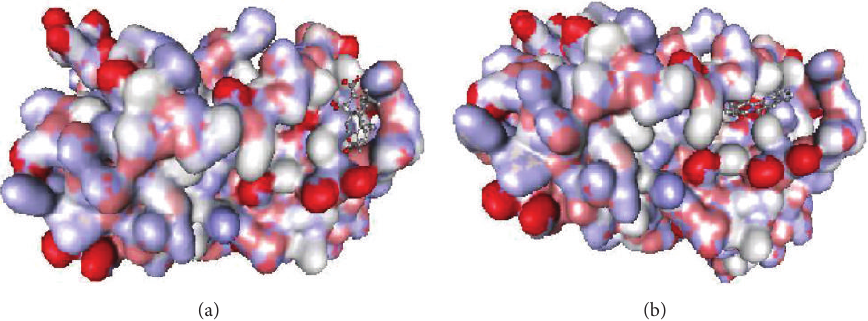
Figure 5: RAD9 and ligands interacting conformations (a), RAD9 and NSC15520 interacting complex, and (b) RAD9 and camptothecin interacting complex.